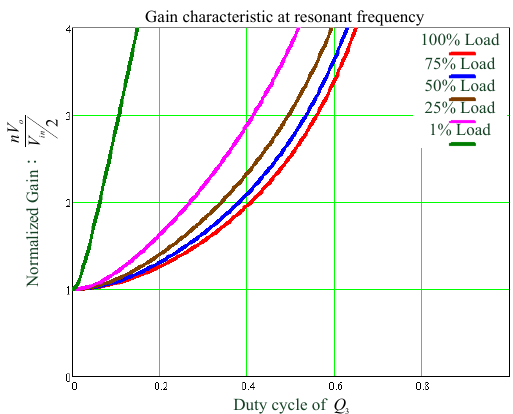
Figure 18. Characteristic plots of system gain that changes with load.